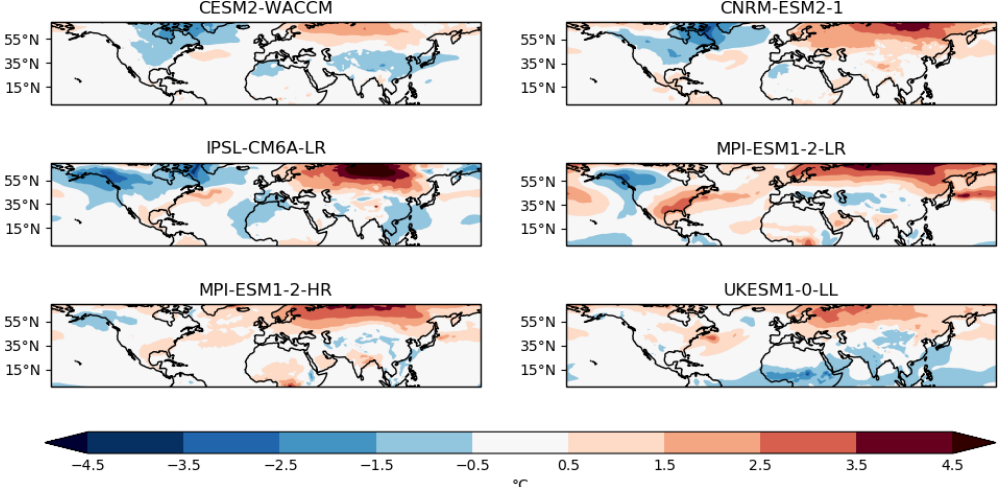
Figure 3. G6sulfur minus ssp245 difference in 2081–2100 mean December to February near-surface air temperature ( ◦ C) for each model. The area plotted replicates that presented by Jones et al. (2021; their Fig. 8) to concentrate on the area affected by the